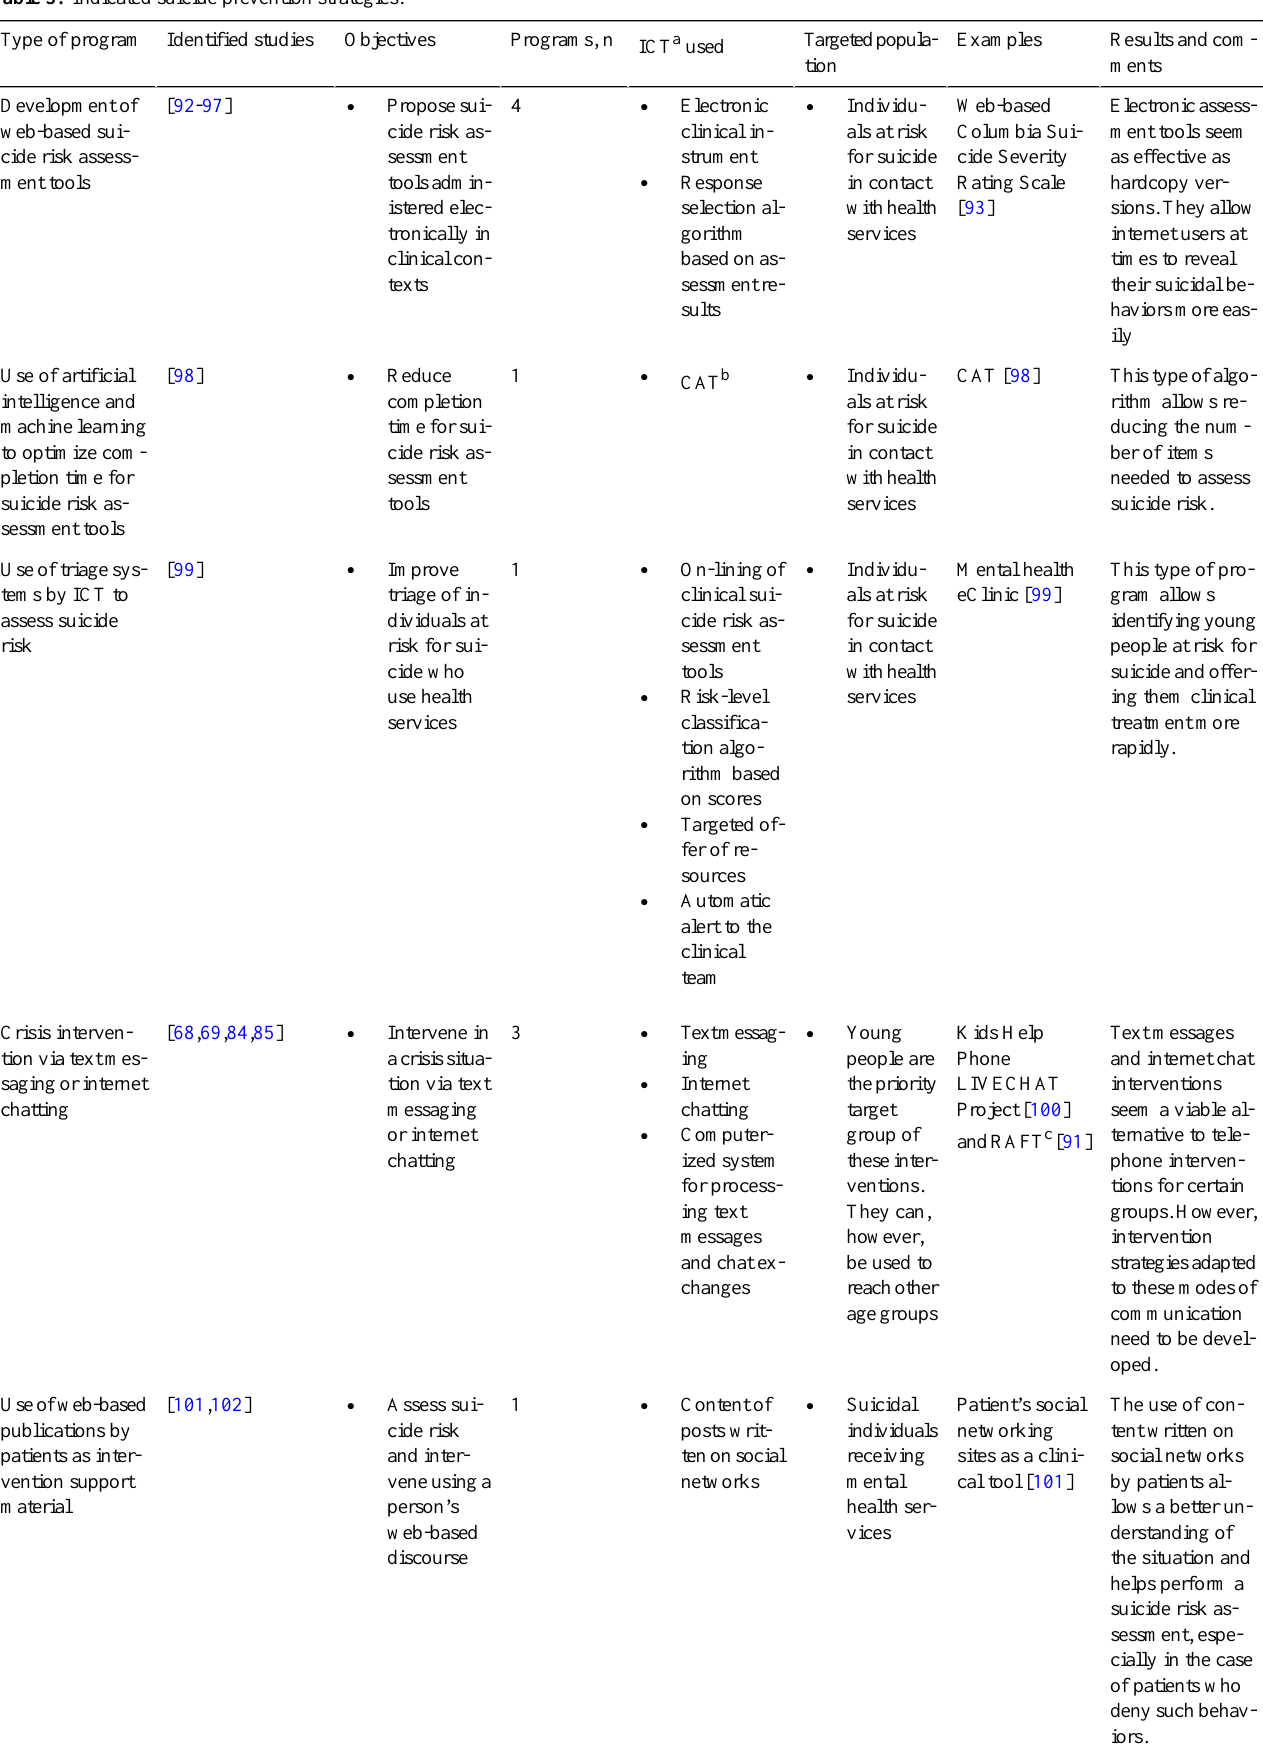
Table 3. Indicated suicide prevention